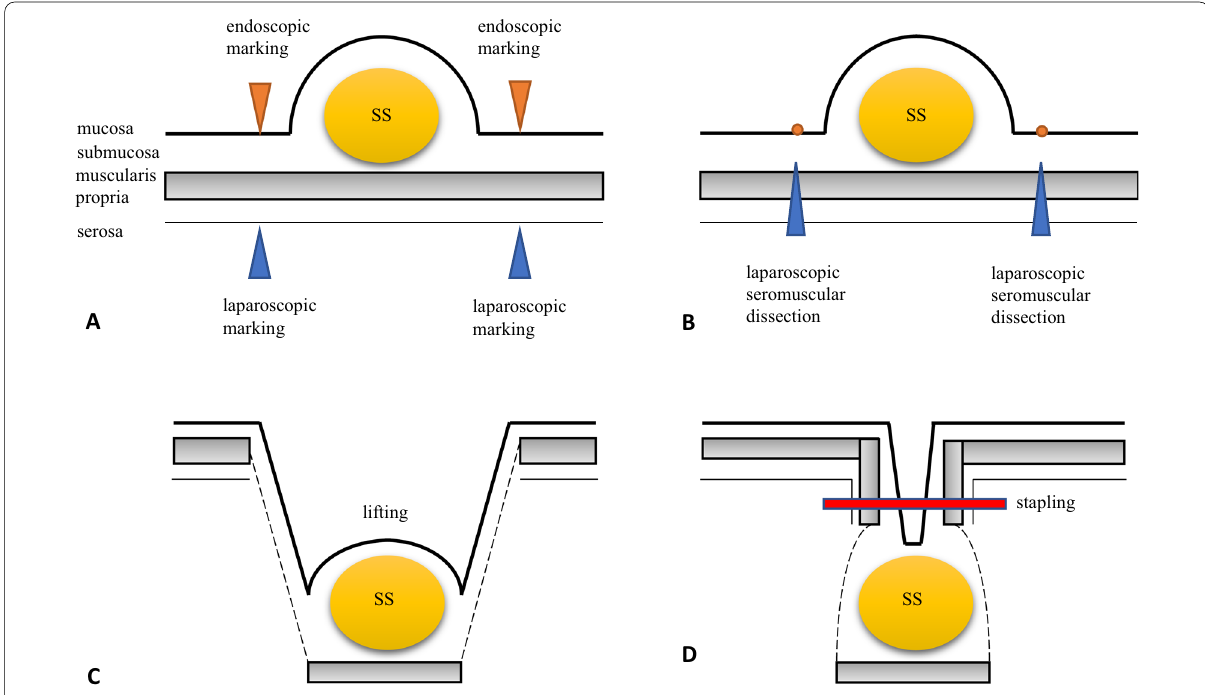
Fig. 4 Scheme of the combination of laparoscopic and endoscopic approaches to neoplasia with a non-exposure technique (CLEAN-NET) procedure. A An endoscopic marking around the tumor from within the lumen of the stomach and laparoscopic marking around the tumor on the serosa contributed to the endoscopic confirmation of the resection line. B Laparoscopic seromuscular dissection around the tumor along the resection line. C The tumor was lifted toward the abdominal cavity for obtaining definite margin-free resection. D Full-layer resection of the stomach with a laparoscopic linear stapling